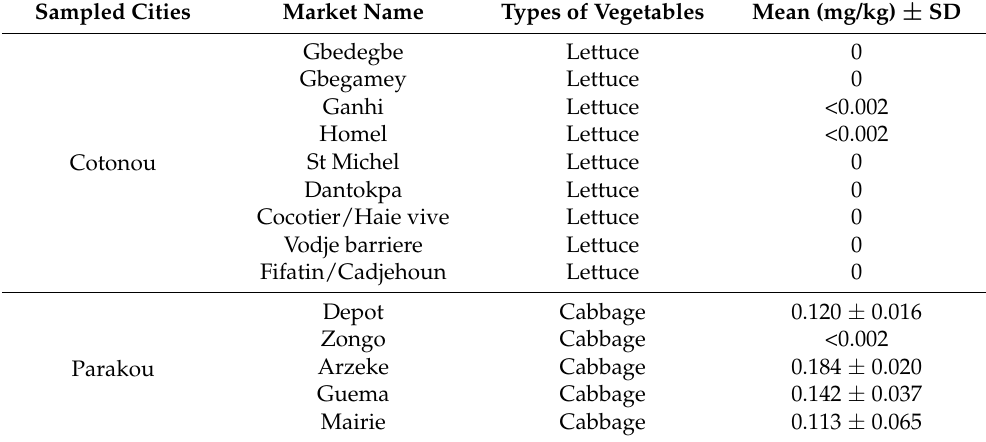
Table 3. λ -cyhalothrin levels in lettuces and cabbages sampled at vegetable markets in Cotonou and Parakou.